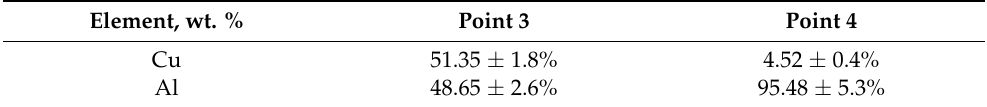
Figure 4. SEM images of a cross section of sample 2 (0.2 mm radius of oscillation): ( a ) SEM image of the obtained joint; ( b ) higher magnification SEM image of the copper–fusion zone (FZ) interface; ( c ) higher magnification SEM image of the fusion zone (FZ); ( d ) higher magnification SEM image of the fusion zone (FZ)–aluminum alloy interface; ( e ) SEM image of a magnified section of the fusion zone (FZ). Table 3. Chemical composition of each point marked on the SEM images of the fusion zone of sample 2 in Figure 4e.